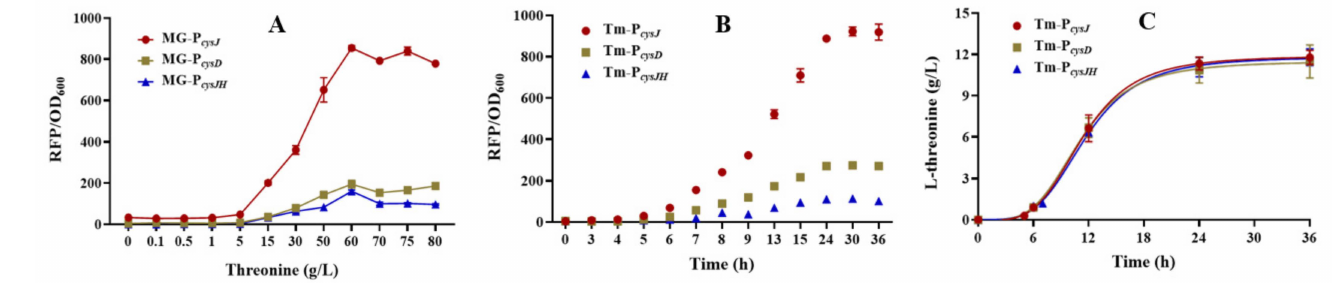
Figure 3. Characterization of the L-threonine-sensing promoters P cysJ , cysD , and cysJH . ( A ) Plasmids P cysJ - rfp , P cysD - rfp , and P cysJH - rfp were introduced into E. coli K-12 MG1655 to construct MG-P cysJ , MG-P cysD , and MG-P cysJH for characterization by adding 0–80 g/L L-threonine. Strain MG-cl contain- ing the empty plasmid pCL1920 was the control for removing the background value of RFP/OD 600 . ( B ) The sensing curves of the three promoters were monitored in the strains Tm-J, Tm-D, and Tm-JH containing the plasmids P cysJ - rfp , P cysD - rfp , and P cysJH - rfp . ( C ) Monitoring of the L-threonine concen- trations of Tm-J, Tm-D, and Tm-JH during the fermentation process. All results were calculated